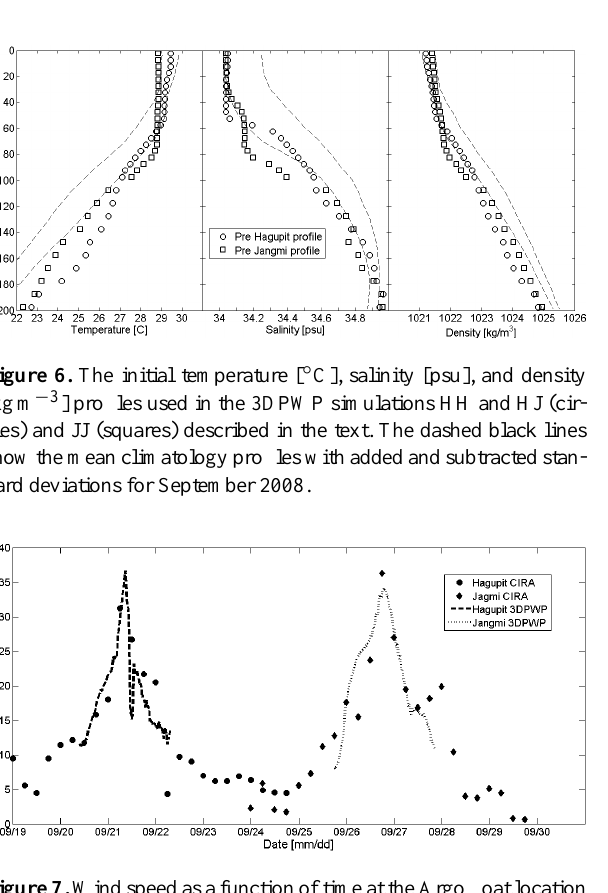
Figure 7. Wind speed as a function of time at the Argo float location (17.5 ◦ N, 126.5 ◦ E) based on observations and model results. The dots and diamonds represent CIRA data for typhoons Hagupit and Jangmi every 6h. The dashed and dotted lines are wind speeds used in the model forcing (based on only one initial velocity field, but advected with the center of TC movement) for typhoons Hagupit and Jangmi, respectively.